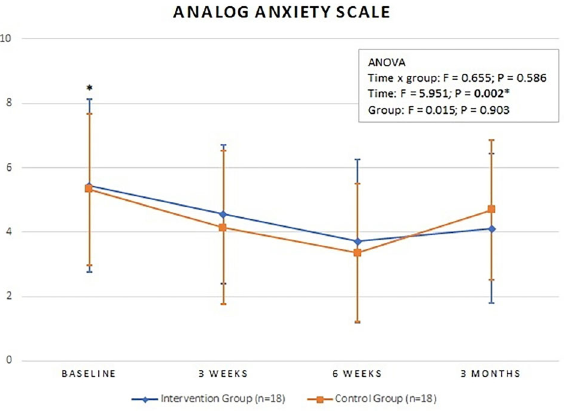
Figure 5. Mean values of the Visual Analog Anxiety Scale at baseline, 3 weeks, 6 weeks, and 3 months. Intervention